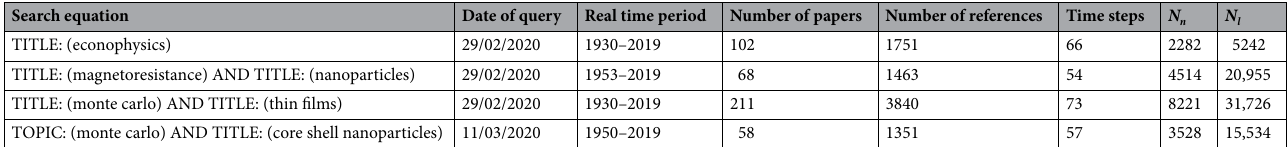
Table 1. Search information for each network. WoS source.